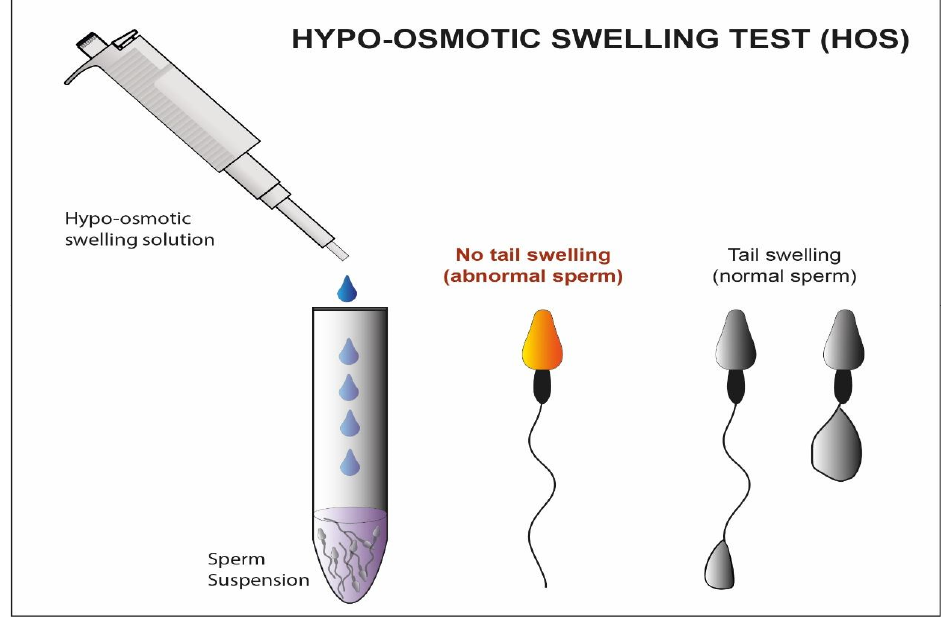
Figure 2. Schematic representation Hypo-osmotic swelling Test. In this figure, we observe the difference between the abnormal sperm with not swelled tail and the normal sperm with swelled tail after treatment with a hypo-osmotic solution.